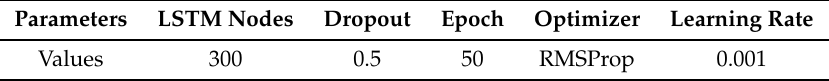
Table 10. Hyper-parameters settings for Author Model [5].